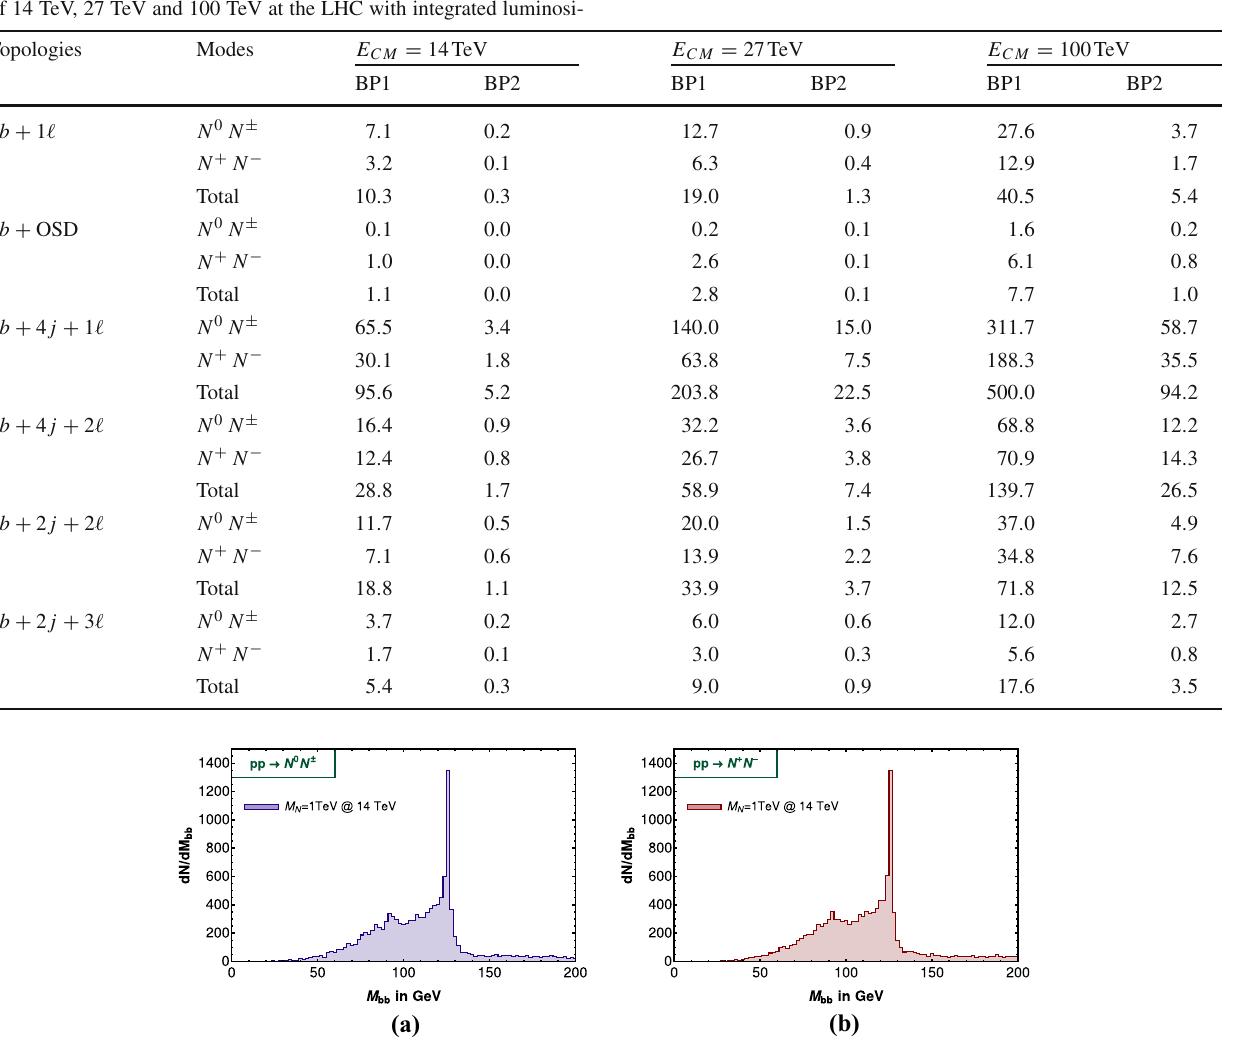
Fig. 14 Di- b -jet invariant mass ( M bb ) distributions for the process p p → N 0 N ± ( a ) and p p → N + N − ( b ) at the LHC with M N = 1 TeV (BP1), Y N = 5 × 10 − 7 and center of mass energy of 14 TeV. The